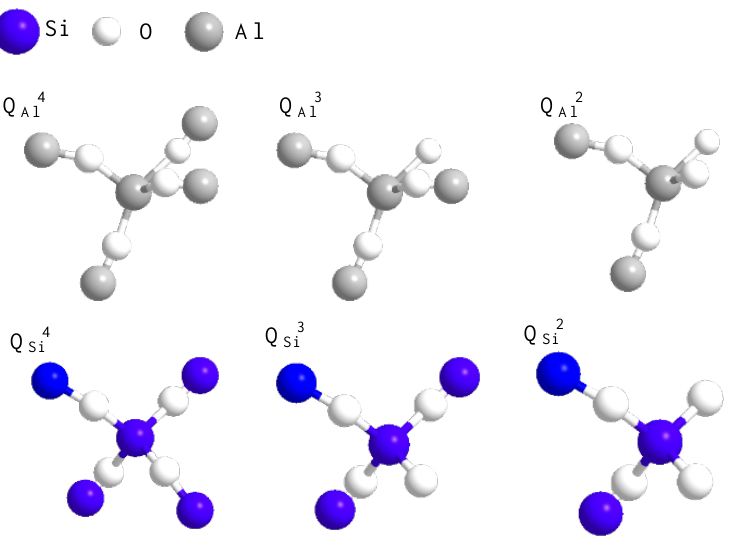
Figure 9. Stick model of aluminate and silicate crystals.